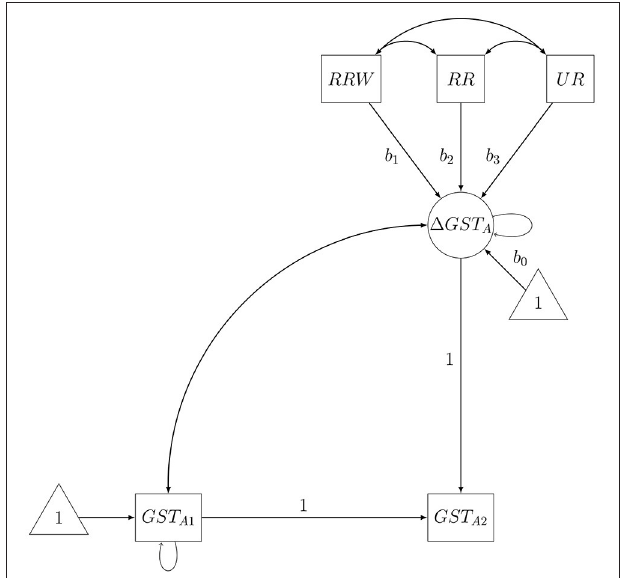
FIGURE 3 | Exemplary latent change model for testing H1. Latent change in epistemic beliefs 1 GST A (i.e., latent change in absolutism on the FREE-GST) is predicted by dummy-coded variables indicating group membership (i.e., RRW for “Resolvable Read and Write”, RR for “Resolvable Read” and UR for “Unresolvable Read”). Latent change itself is operationalized as the part of an observed outcome variable GST A 2 (i.e., absolutism on the FREE-GST post-intervention) that differs from its pre-intervention measurement GST A 1 (i.e., absolutism on the FREE-GST